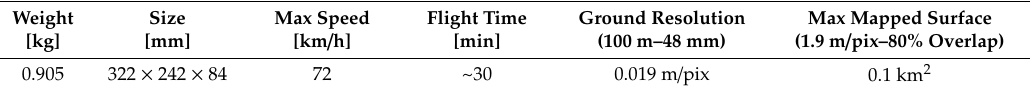
Table 1. Main characteristics of the DJI Mavic TM .